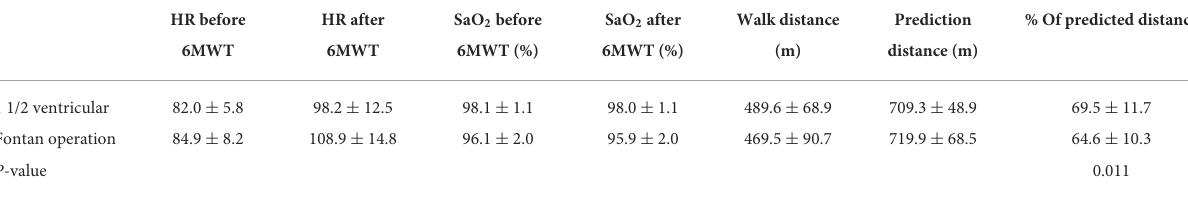
TABLE 6 Outcome of 6-min walk test. Prediction